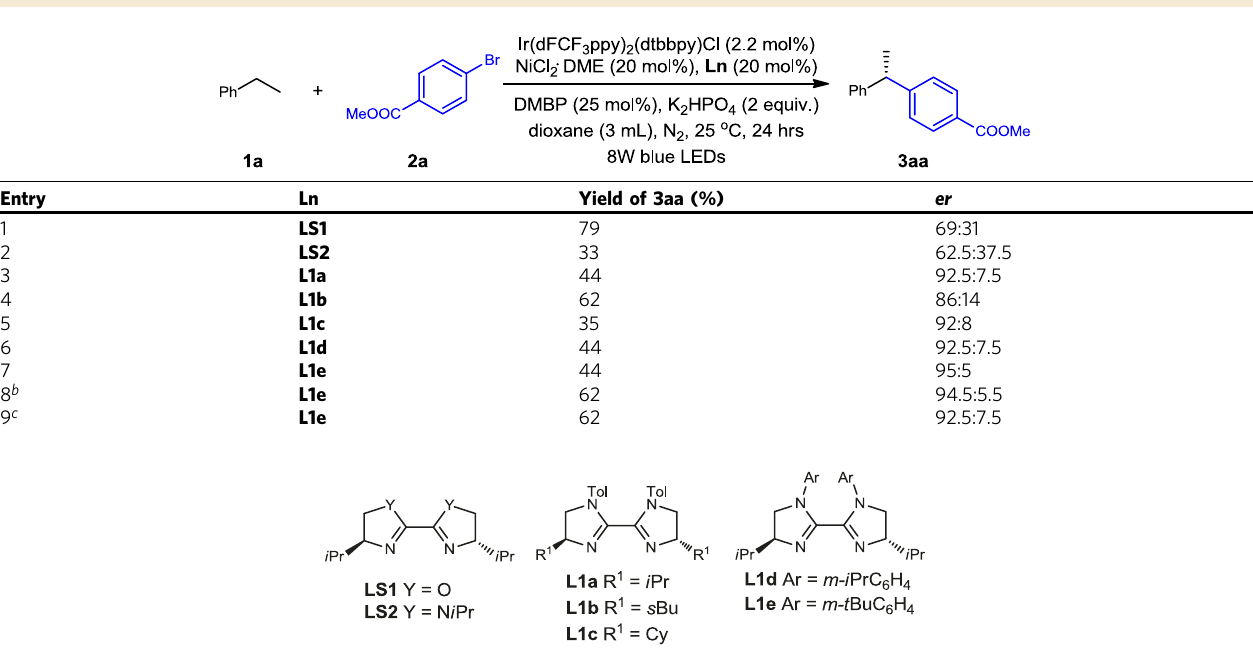
Table 1 Selected chiral ligand screening results